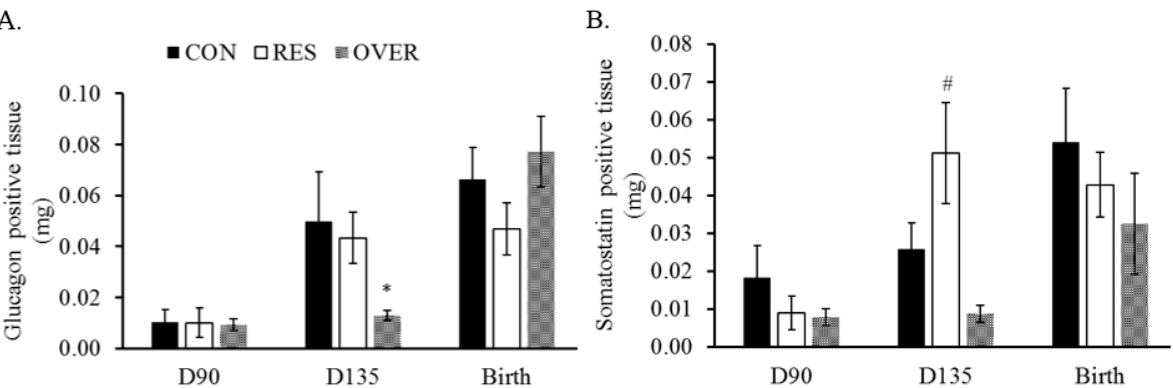
Figure 3. Maternal over-nutrition reduces glucagon positive area and maternal under-nutrition increases somatostatin positive tissue in the pancreas of offspring. Glucagon positive ( A ) and somatostatin positive tissue ( B ) were quantified, and images were false colored using ImageJ. Data were normalized using pancreas mass. * p ≤ 0.05, # 0.05 < p ≤ 0.10 compared with CON.